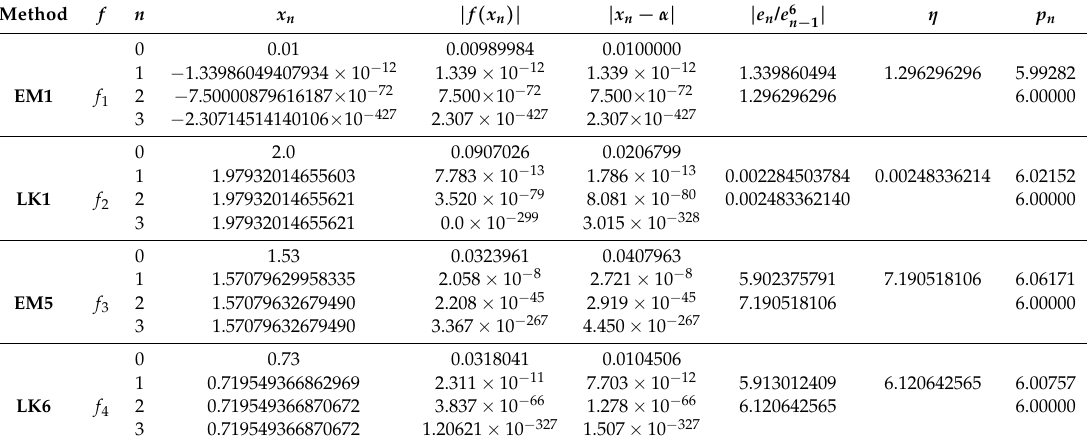
Table 2. Convergence for test functions f 1 ( x ) − f 4 ( x ) with typically selected Methods EM1, LK1, EM5, LK6